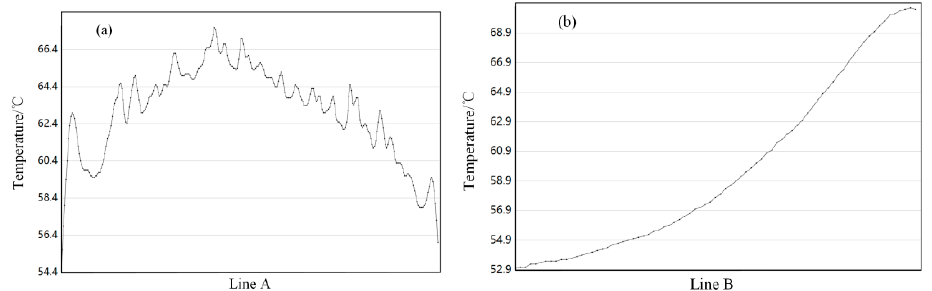
Figure 12. The temperature–variation curve at pressure 50 kPa in the ( a ) horizontal and ( b ) vertical directions.